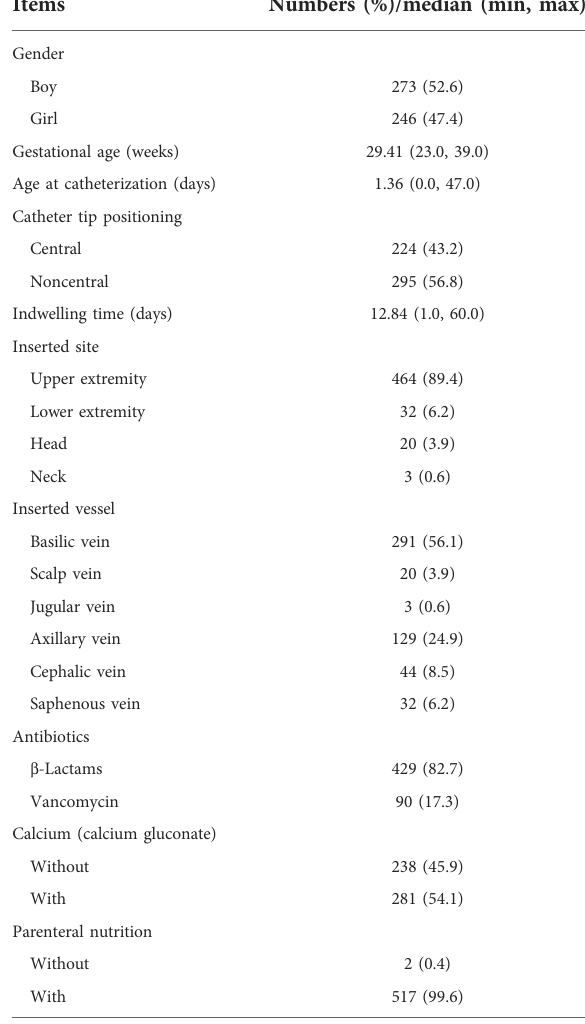
TABLE 1 Characteristic of ELBW/VLBW infants ( n